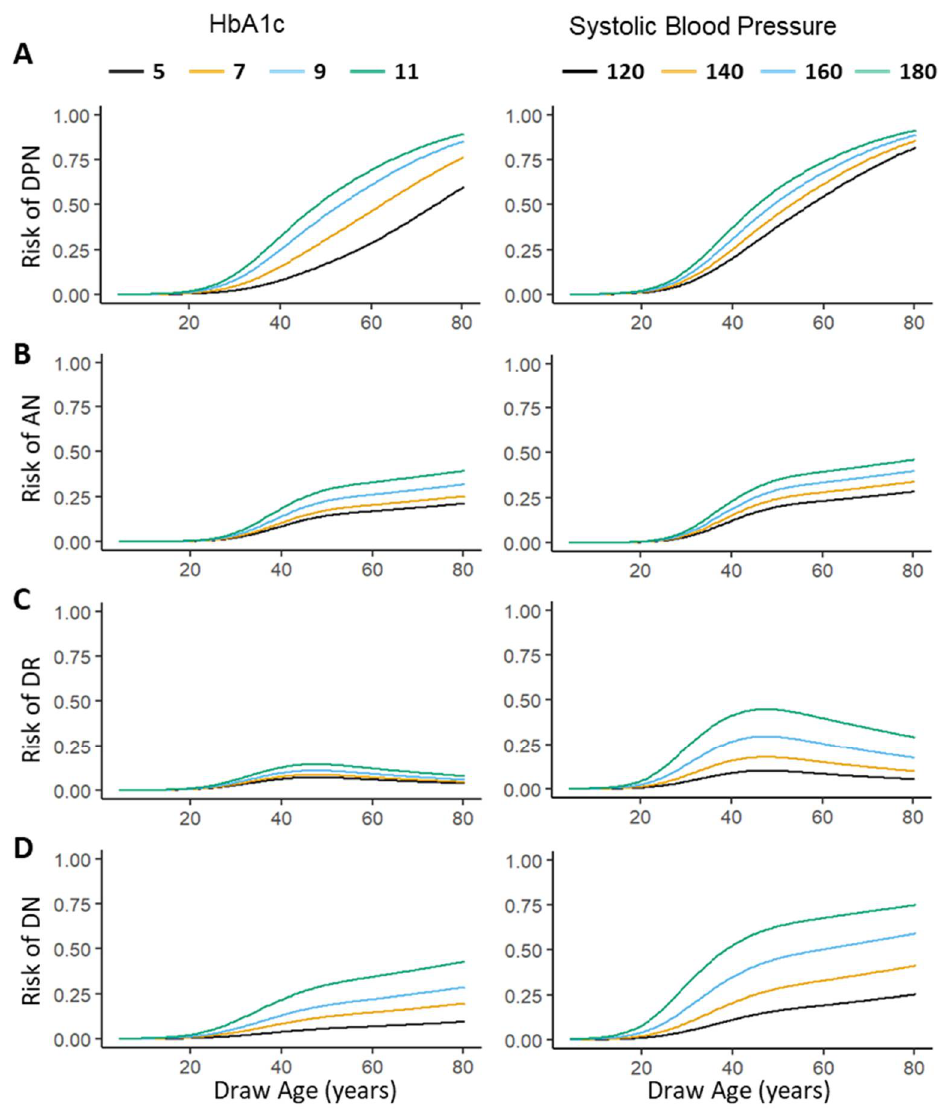
Figure 2. Predicted risk of DPN ( A ), AN ( B ), DR ( C ), and DN ( D ) with increasing HbA1c ( left ) and systolic blood pressure ( right ). We applied the four logistic microvascular complication models to simulated data by fixing the mean and standard deviation of the simulated data to that of the PAGODA population and varying the patient age at day of sample and our variables of in- terest, HbA1c and systolic blood pressure. We tested HbA1c at 5, 7, 9, and 11. We tested systolic blood pressure at 120, 140, 160, and 180. The gray zones show the 95% confidence interval of the predicted